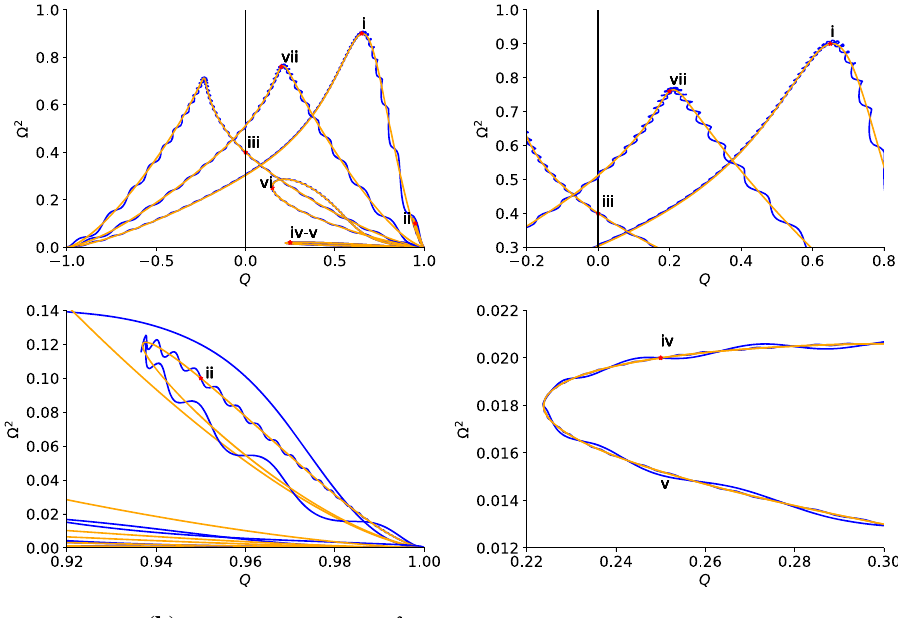
the track of solutions of averaged system (orange lines) for the time interval t D = O ( 1 ) . However, when D becomes infinite ( T → 1) and for γ ≥ 1 solutions of full system (blue lines)departfromsolutionsofaveragedsystem(orangelines) as D becomes large. This is clear because when D becomes